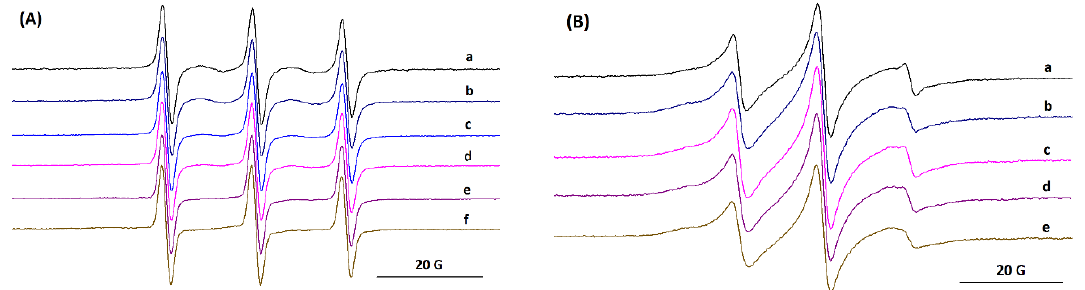
Figure 8. The evolution of the electron paramagnetic resonance (EPR) spectra of ( A ) DIS3: a) initial,